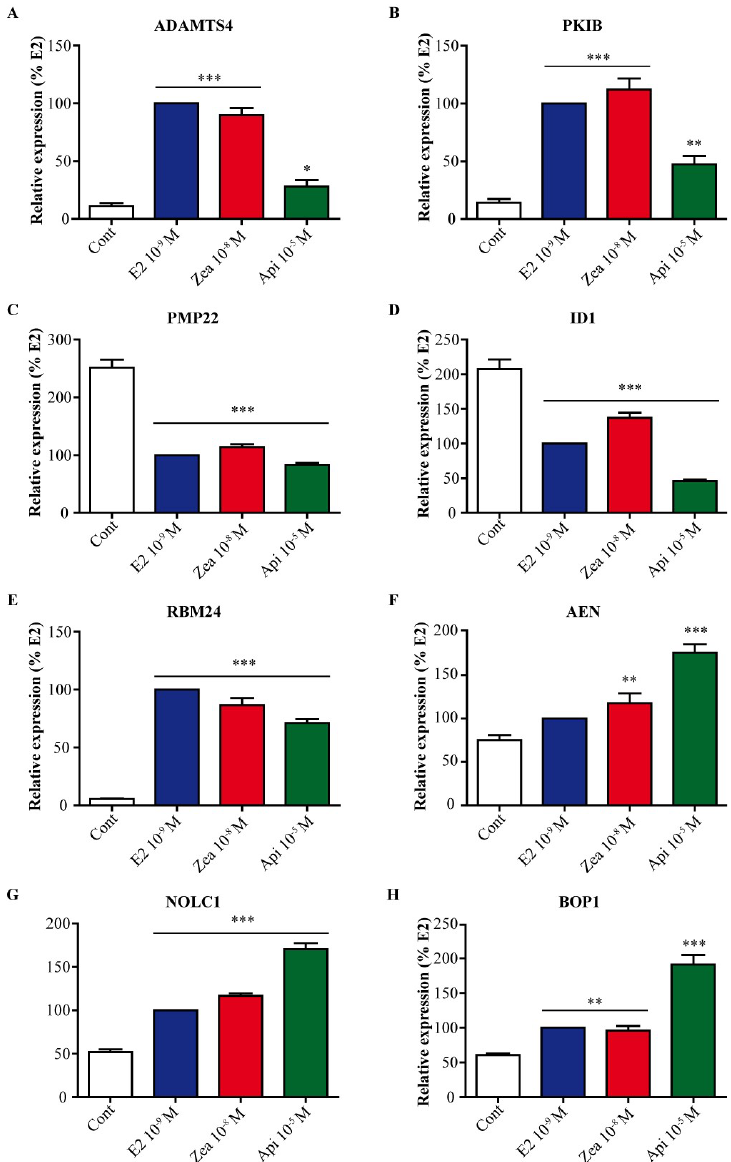
Figure 9. Validation of genes linked to cancer, nucleoli and apoptosis. MCF-7 cells were treated with solvent (white) as a negative control, 10 −9 M E2 (blue) as a positive control, 10 −8 M zearalenone (red) or 10 −5 M apigenin (green) for 24 h. The expression of ADAM metallopeptidase with thrombospondin type 1 motif 4 (ADAMTS4) ( A ), CAMP-dependent protein kinase inhibitor beta (PKIB) ( B ), peripheral myelin protein 22 (PMP22) ( C ), inhibitor of differentiation 1 (ID1) ( D ), RNA binding motif 24 (RBM24) ( E ), apoptosis-enhancing nuclease (AEN) ( F ), nucleolar and coiled-body phosphoprotein 1 (NOLC1) ( G ) and block of proliferation 1 (BOP1) ( H ) was assessed by real-time PCR. The expression level of each gene was normalized to the expression levels of the housekeeping genes GAPDH and TBP. The results are expressed as the percentage of the relative expression of transcripts obtained in E2-treated cells and are the means ± SEM of six independent experiments. * indicates a p -value < 0.05, ** indicates a p -value < 0.01 and *** indicates a p -value < 0.001 by one-way ANOVA followed by Dunnett’s post hoc test for comparison of the control treatment with the other